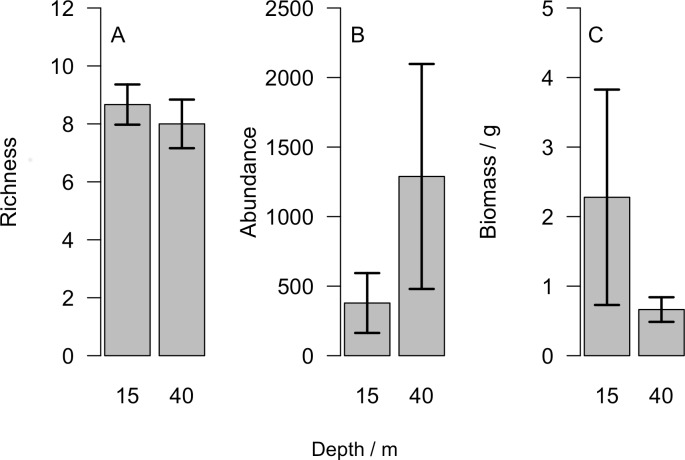
(A) Number of different taxonomic groups recorded, (B) mean abundance per light trap and (C) total biomass across all taxa groups comparing reefs at 15 m and 40 m.Bars show mean ±1 standard error.